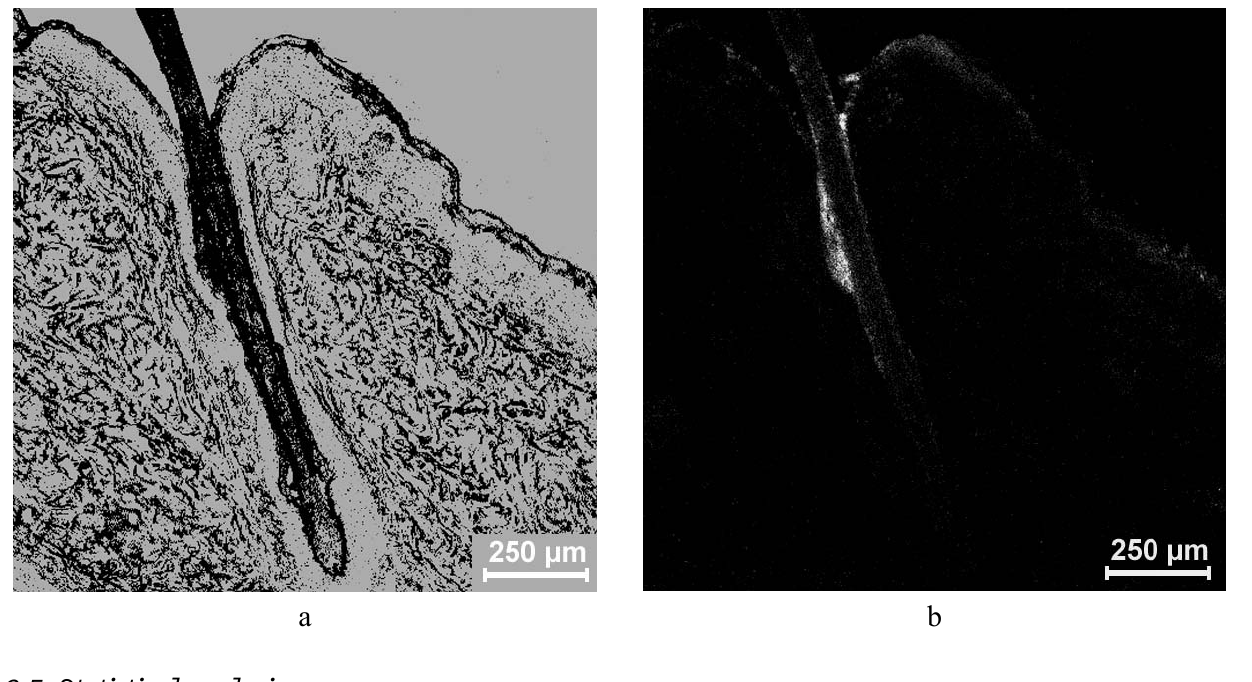
Figure 1. Images of a longitudinal section of a hair follicle taken in the transmission ( a ) and the fluorescence mode ( b ) by laser scanning